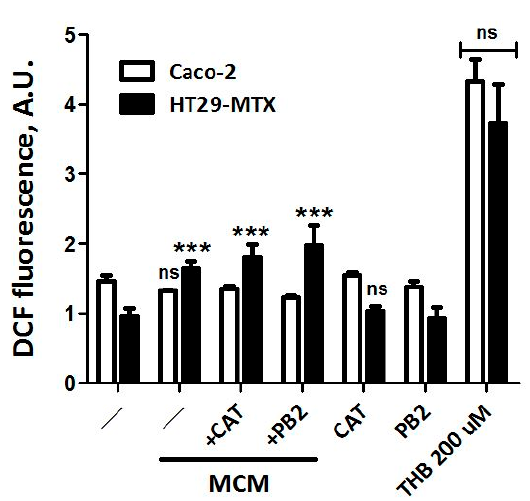
Figure 5. ROS production in Caco-2 and HT29-MTX cells: Effect of MCM. The day after seeding, CAT and PB2 were added to the culture medium at a concentration of 50 µM. After 24 h, medium was removed and cells were incubated for 1 h at 37°C. in pre-warmed Hank’s balanced salt solution (HBSS), containing CM-H2DCFDA (10 µM). The loading buffer was removed and substituted with control medium or MCM, in the absence or in the presence of CAT or PB 2 , as indicated. THB (200 µM) was used for positive control. Data are means of four independent determinations with SD shown. *** p < 0.001 vs. control, untreated culture of relative Caco-2 or HT29-MTX cells.